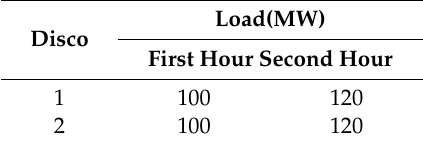
Table 4. Disco’s demand in two consecutive